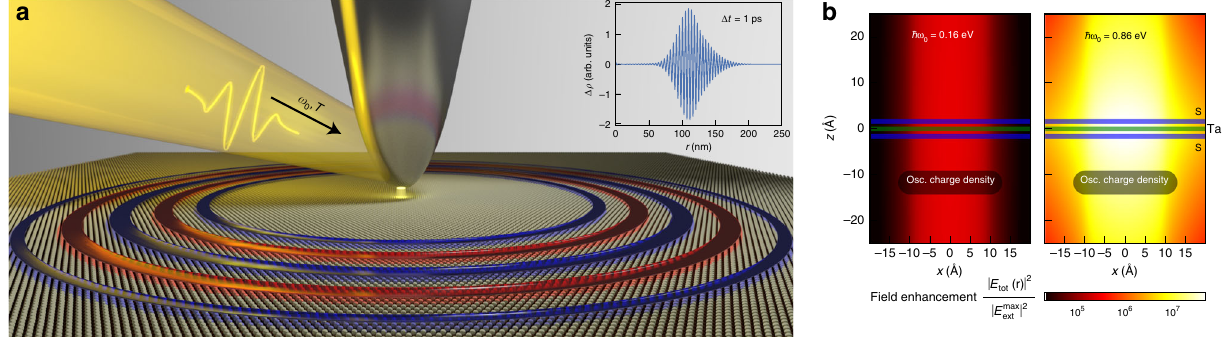
Fig. 5 Slowly moving plasmon wave packet excited on monolayer TaS 2 . a Plasmon modes are excited in monolayer TaS 2 with an ultrafast laser pulse (energy (cid:1) h ω 0 ¼ 1 : 02 eV, modulated with a Gaussian pro fi le of width of T = 80 fs), which is coupled to the sample through an AFM tip at ~4 Å above the topmost S atoms. The red and blue regions are schematic representations (not to scale) of the positively and negatively induced charge densities, respectively, that make up the plasmon wave packet at a time Δ t = 1 ps after the external perturbation and are obtained from fi rst principles. Inset shows a cross-sectional plot of the computed induced charge density which highlights that, 1 ps after the excitation, the plasmon wave packet only traveled ~100 nm and is still localized on a disk ~20 nm thick. b Field enhancement due to slow plasmons in monolayer TaS 2 . An external fi eld is produced by an oscillating charge density, in the steady-state regime, with frequency ω 0 distributed in a thin disk placed 10 Å below the bottom S layer. The fi eld intensity enhancement, computed from fi rst principles, is evaluated as the ratio of the intensity of the total electric fi eld E (cid:5) (cid:5) (cid:5) (cid:5) 2 . The fi eld intensity enhancement is two orders of magnitude larger and much more con fi ned along the z direction perpendicular to the external fi eld E max ext quasi-2D material when an external fi eld with ħ ω 0 = 0.86 eV excites slower and shorter-wavelength plasmons (right panel), compared to an external fi eld with ħ ω 0 = 0.16 eV which excites faster and longer-wavelength plasmons (left